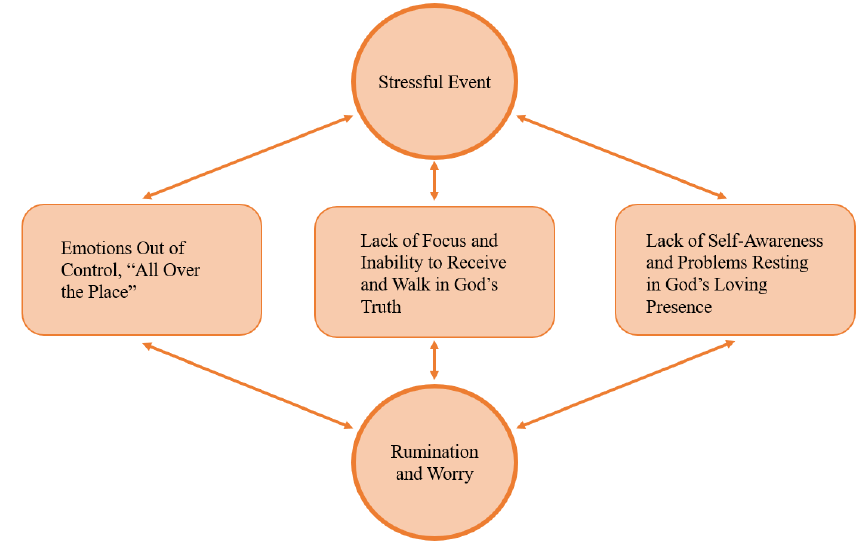
Figure 1. Roles of rumination and worry (adapted from Tang et al. 2015).